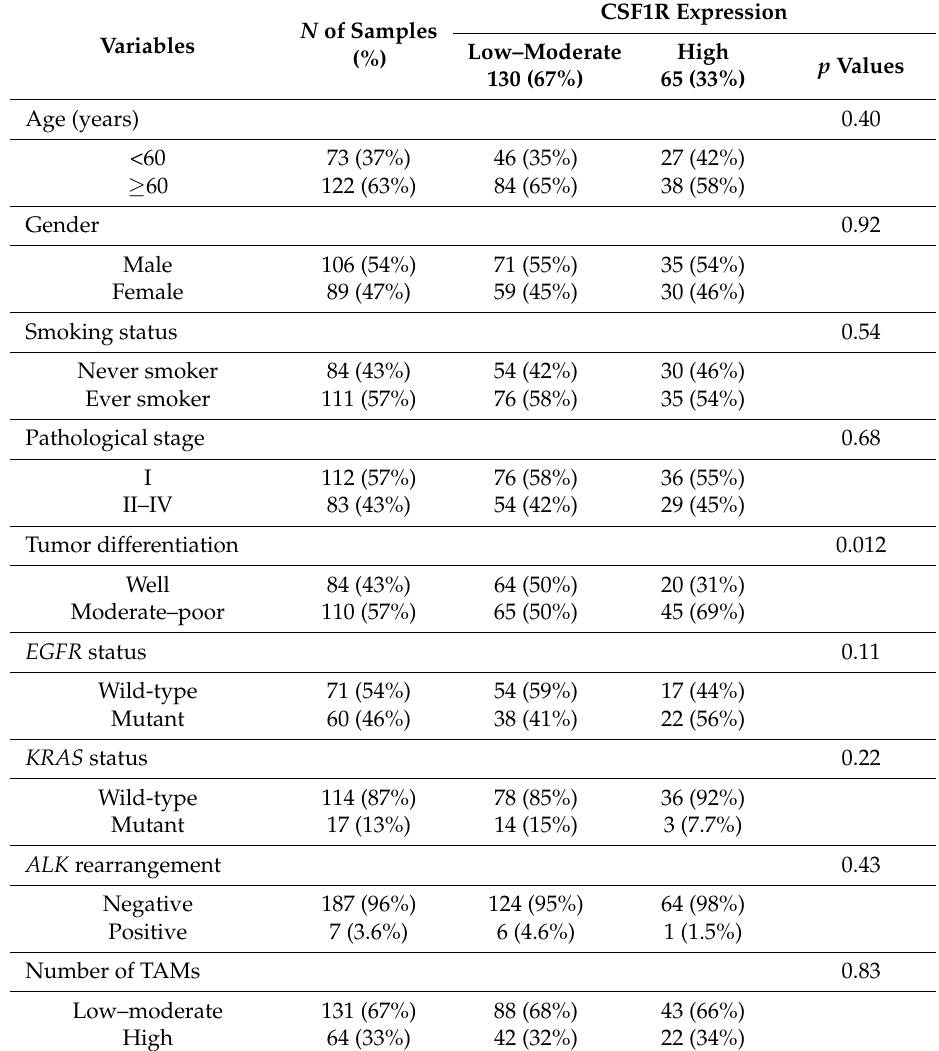
Table 1. Clinicopathological and molecular characteristics of lung adenocarcinoma according to CSF1R expression status in tumor-associated